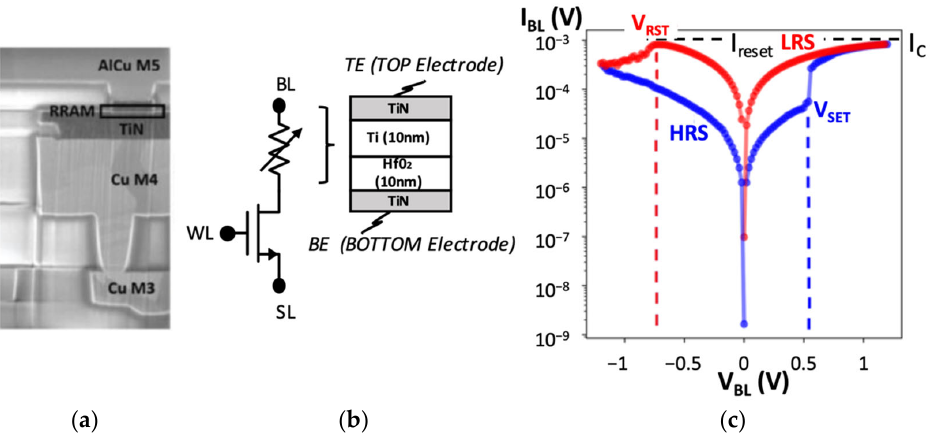
Figure 1. ( a ) TEM cross-section of an OxRAM device; ( b ) symbol view of a 1T-1R cell; ( c ) OxRAM I–V characteristic in log scale. Table 1. Standard operating voltages (cell level, presented in Figure 1b).